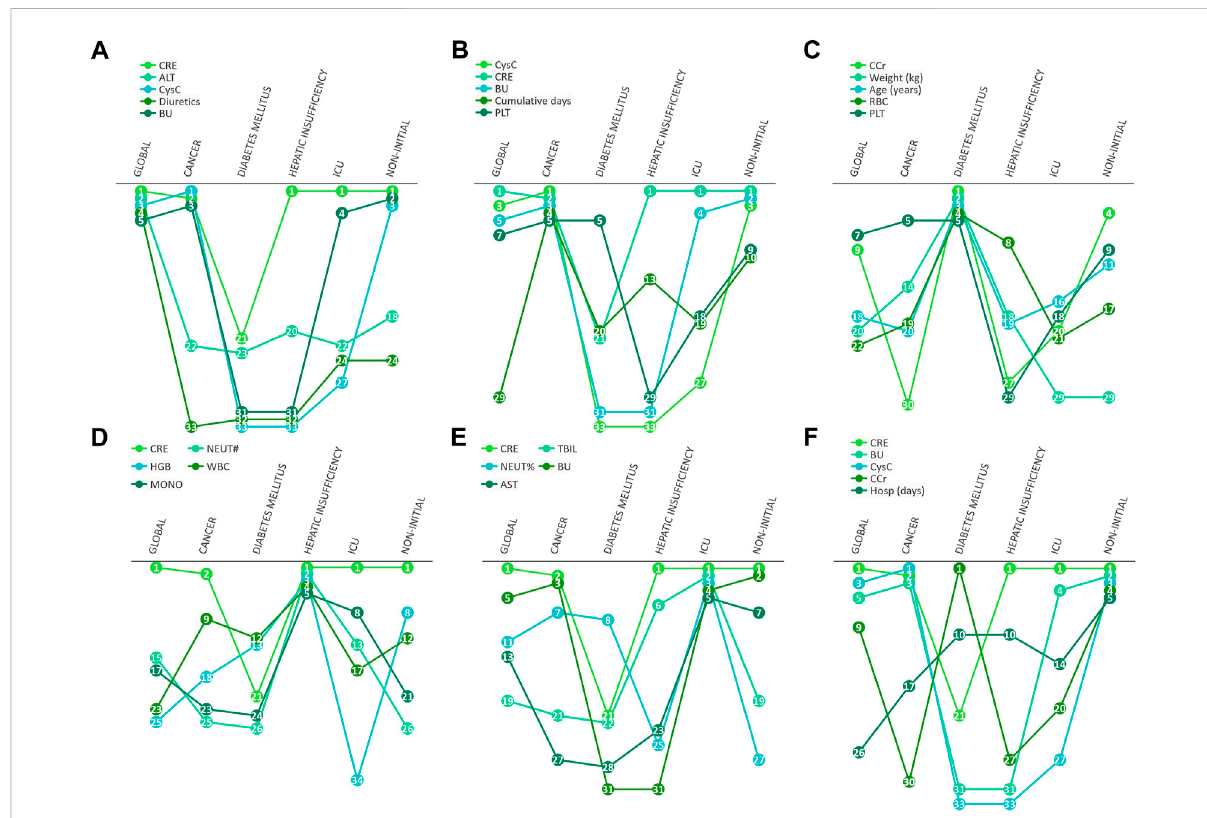
FIGURE 6 Differential manifestations analysis. The number in cycle means the rank number of clinical variables in different underlying